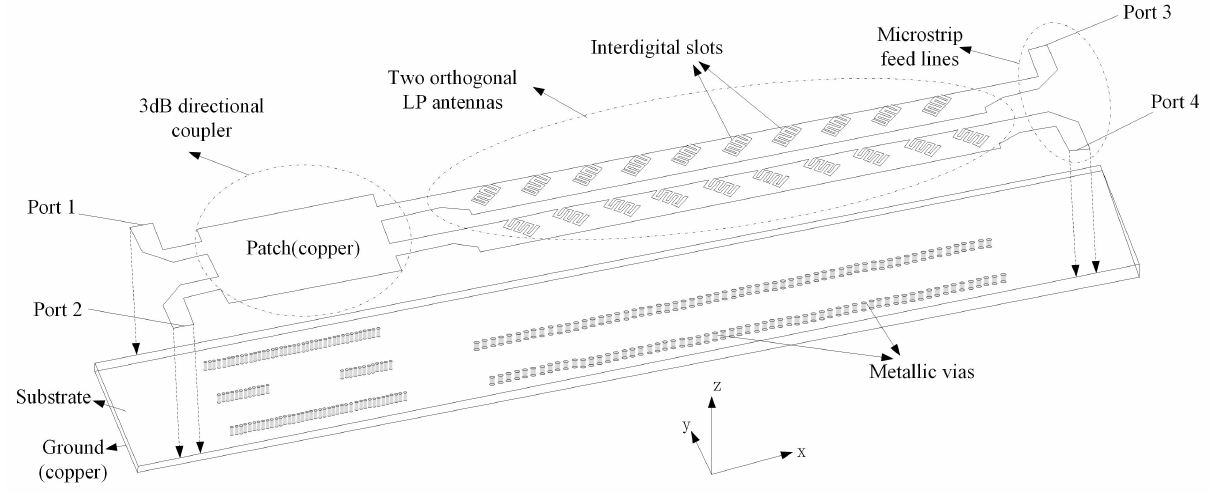
Figure 2. The three-dimensional view of the proposed polarization-flexible and frequency-scanning